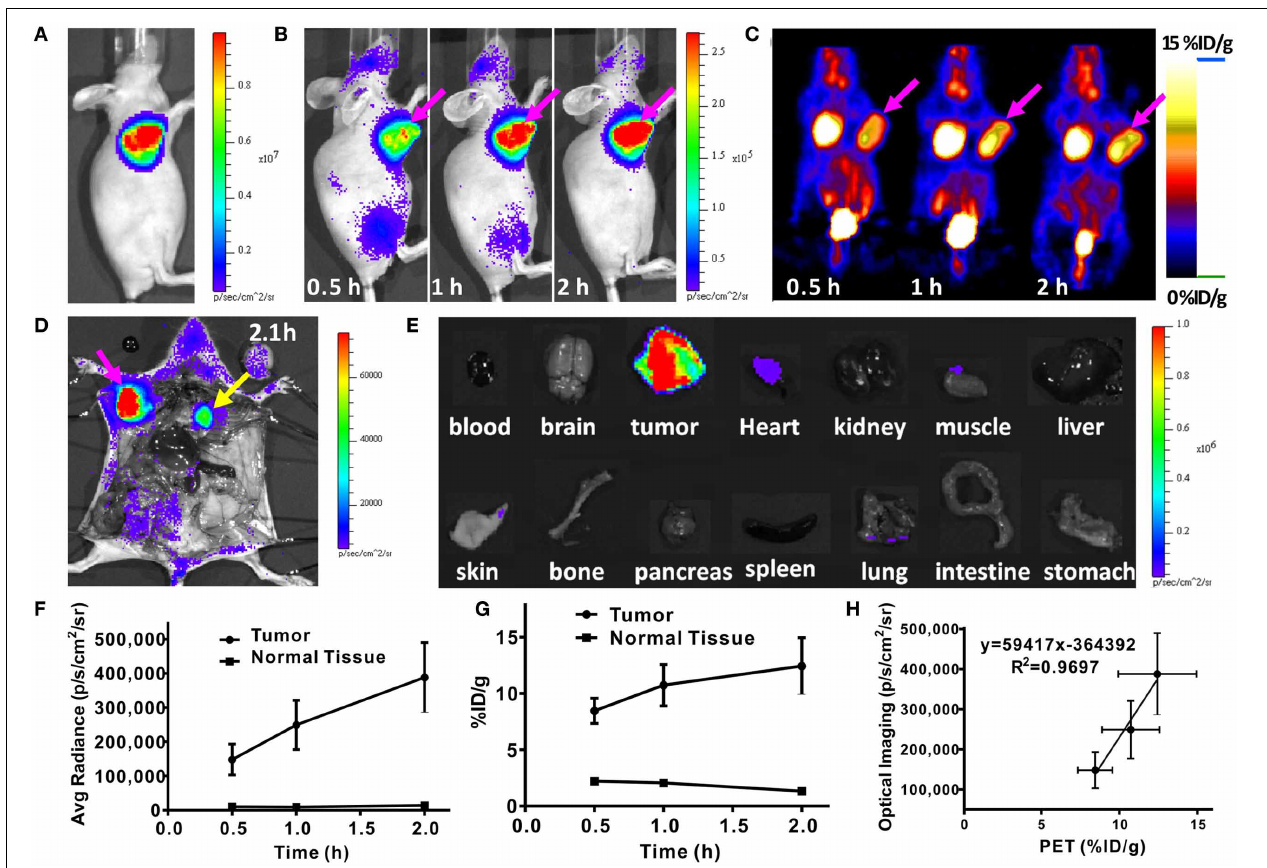
FIGURE 2 | In vivo CLI and microPET of a nude mouse bearing C6-FLuc tumor injected with 18 F-FDG. (A) Luciferase/luciferin bioluminescence image of the tumor. (B) CLI images of the mouse injected via tail vein with 18 F-FDG at 0.5, 1, 2h. (C) MicroPET images of the mouse injected via tail vein